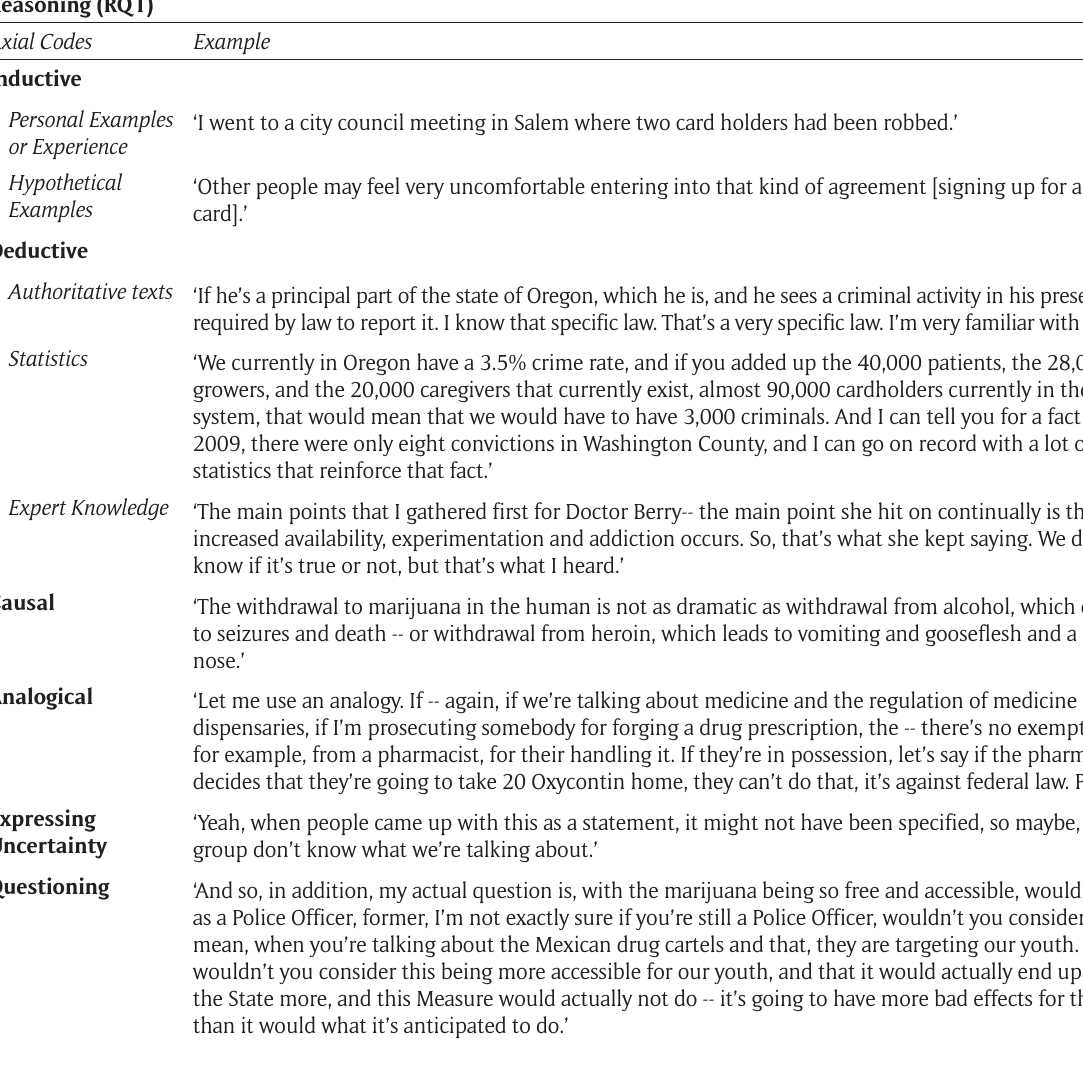
Table 1: Forms of